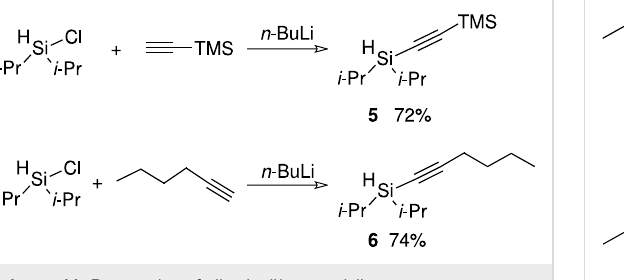
Scheme 11: Preparation of alkynic di iso propylsilanes.